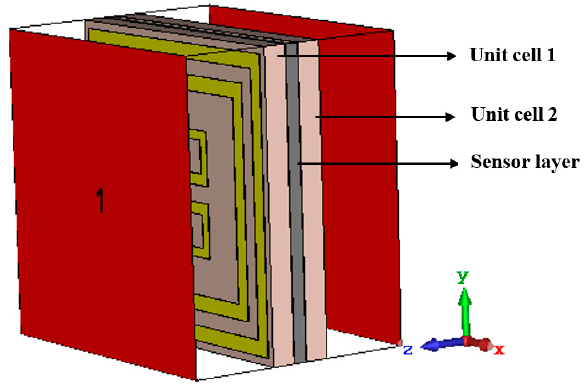
Figure 10. Simulation setup for a pressure sensor using metamaterial absorber unit cell.